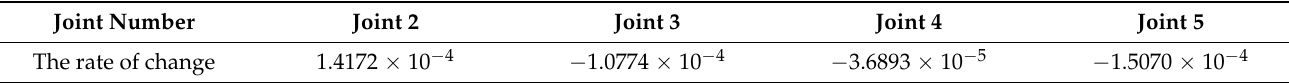
Table 2. The rate of change of each joint at the maximum value of κ ( J AW ) − 1